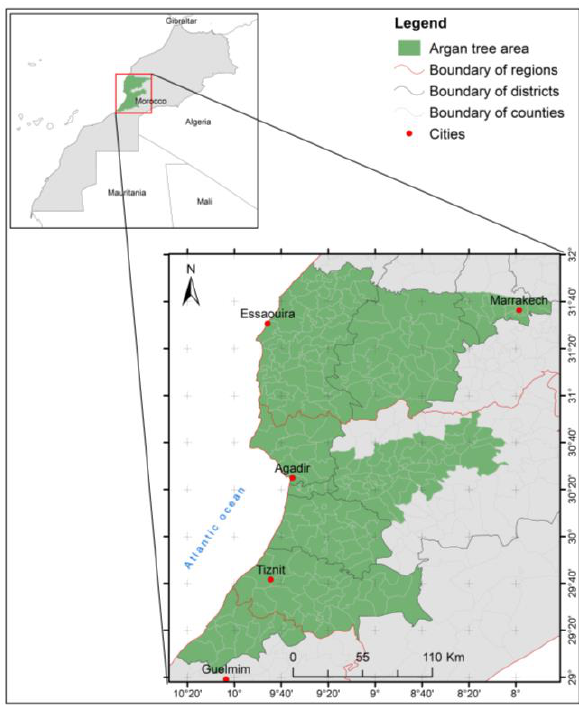
Fig. 1. The geographical and administrative situation of the argan tree